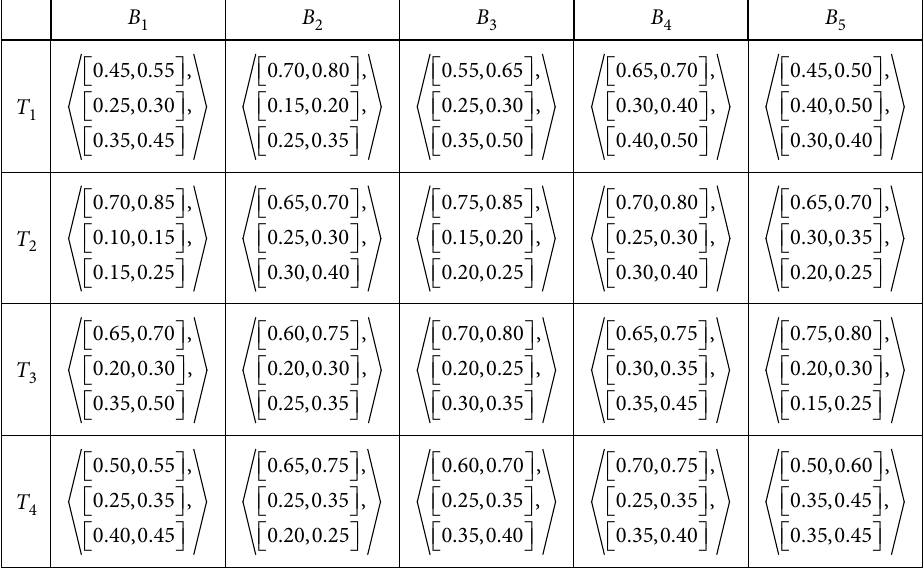
Table 4. Standardized decision matrix